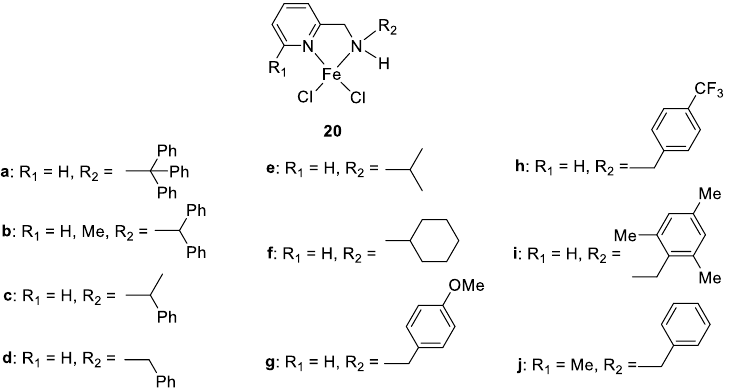
Figure 12. Amine – pyridine iron complexes with mono-substituted amine donors.